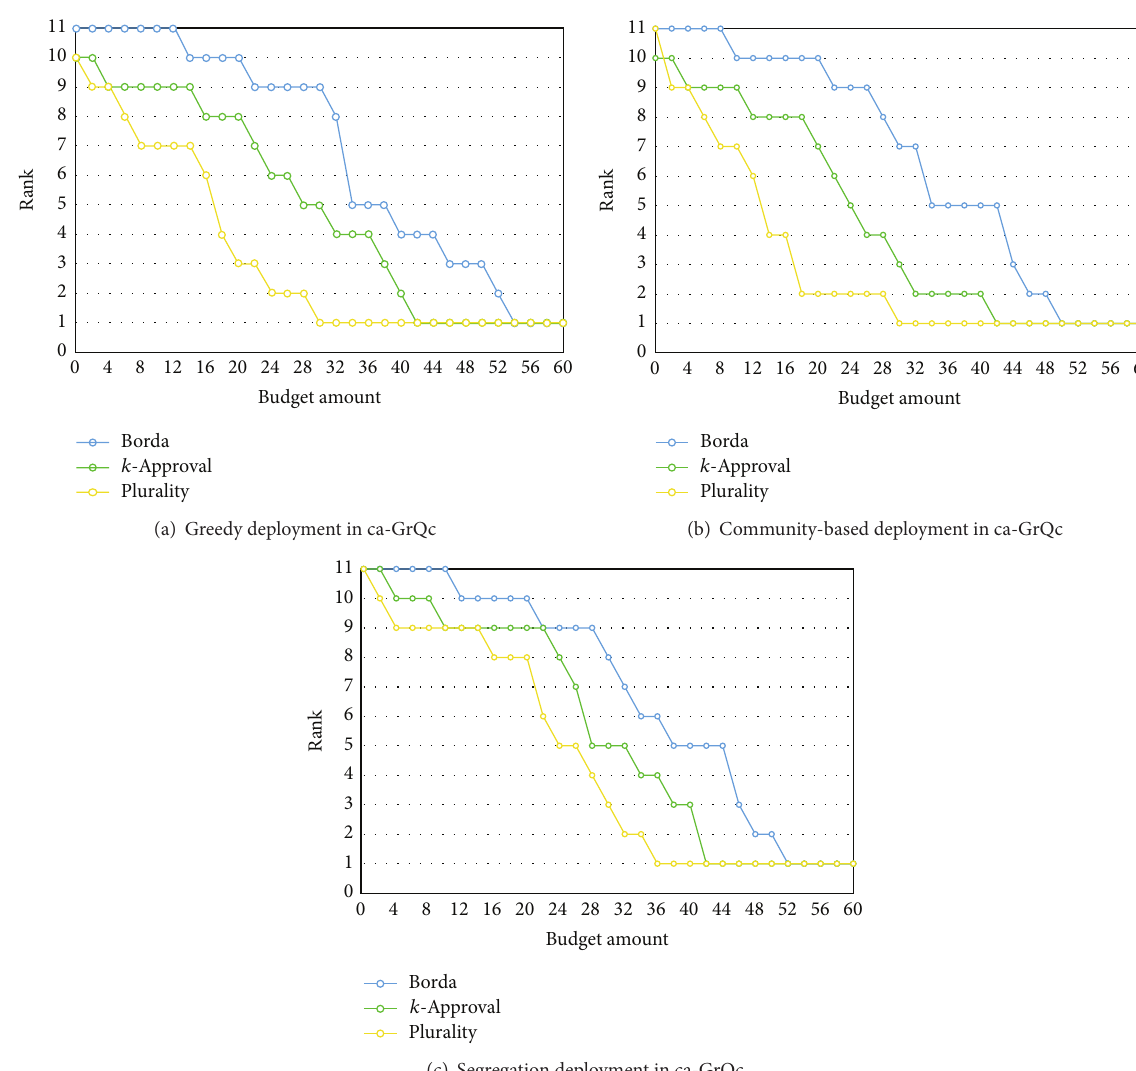
Figure 7: The figure shows the rank of promoted candidate in three voting schemas, where the 𝑥 -axis stands for the budget spent while the 𝑦 -axis stands for the rank of a given candidate for promotion. The figures in each row show the 3rd-round results with different deployments in networks ca-GrQc. The results in networks ca-HepTh and ca-HepPh are consistent. They are excluded due to the